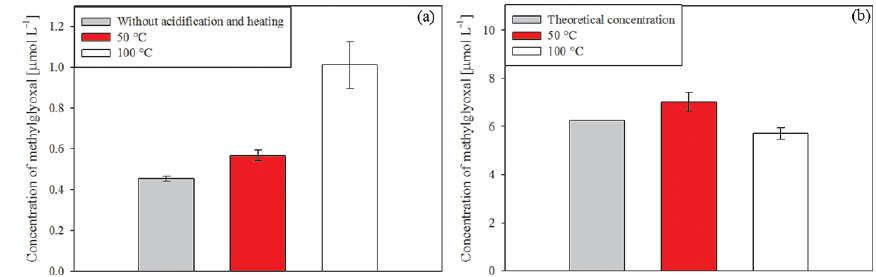
Figure 3. Influence of the heating temperature on the detected methylglyoxal concentration in filter samples (a) and the standard solution (b) .